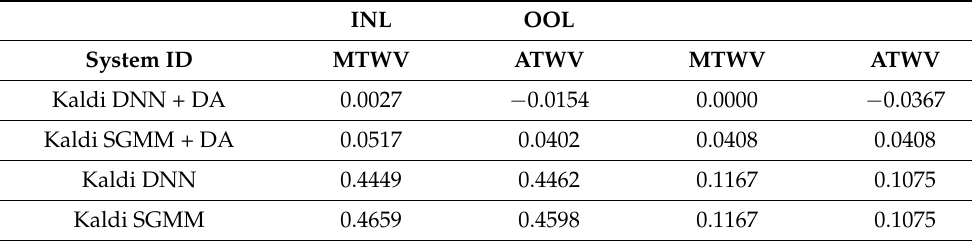
Table 18. System results of the STD task for MAVIR test data for in-language (INL) and out-of- language (OOL)